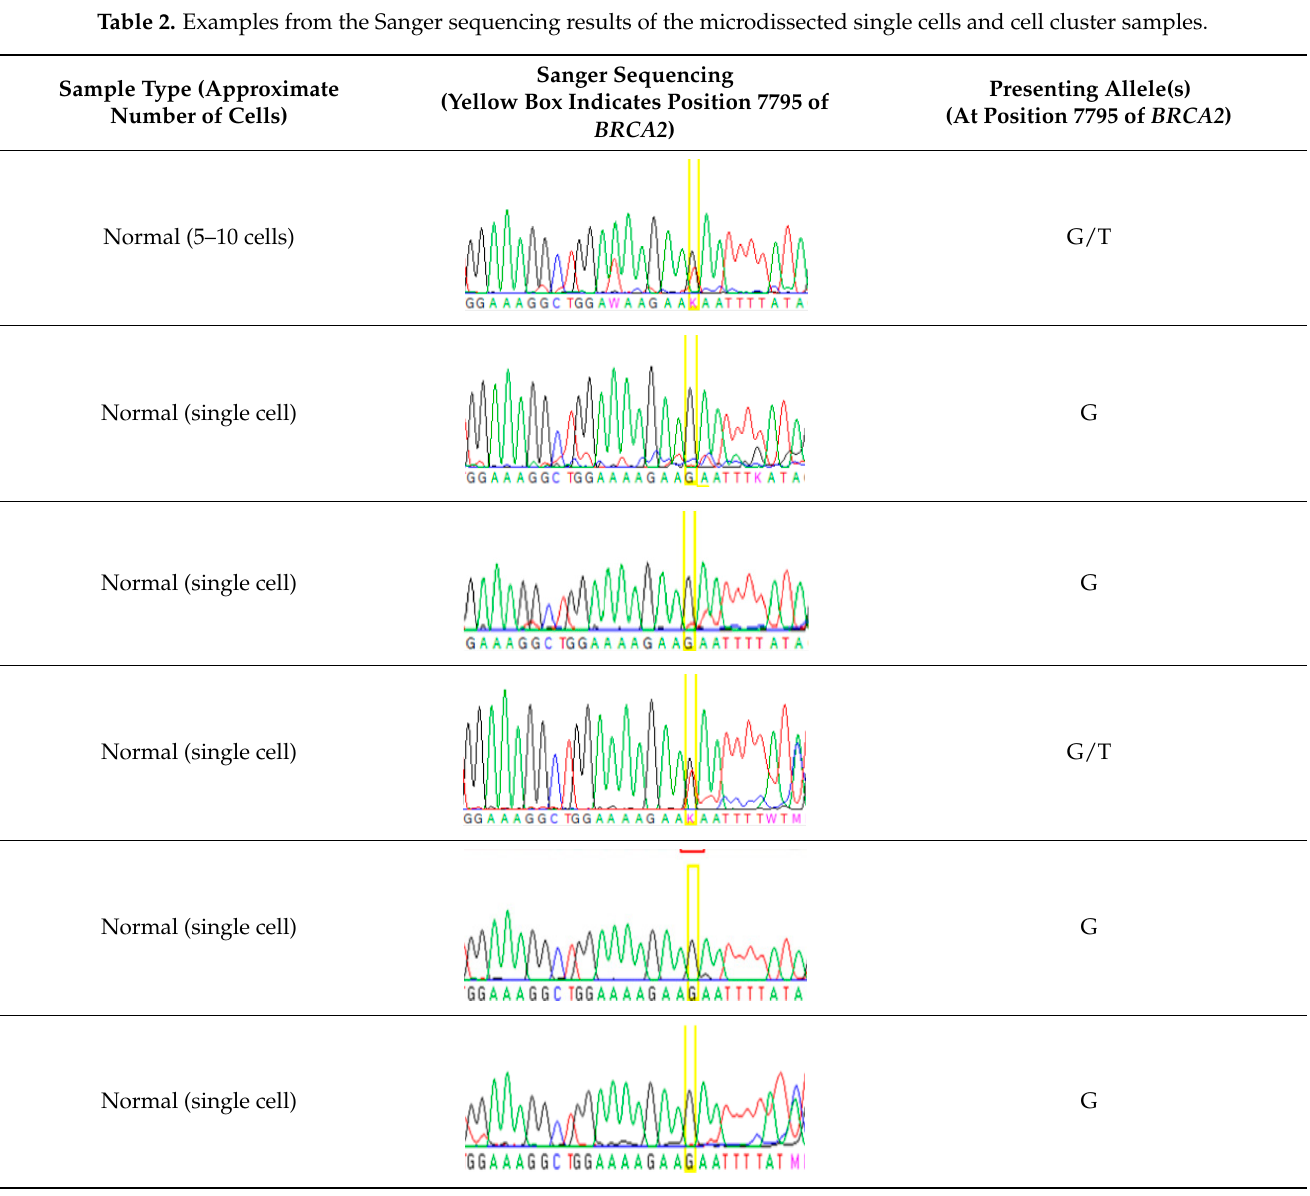
Table 2. Examples from the Sanger sequencing results of the microdissected single cells and cell cluster samples. Sample Type (Approximate Number of Cells)